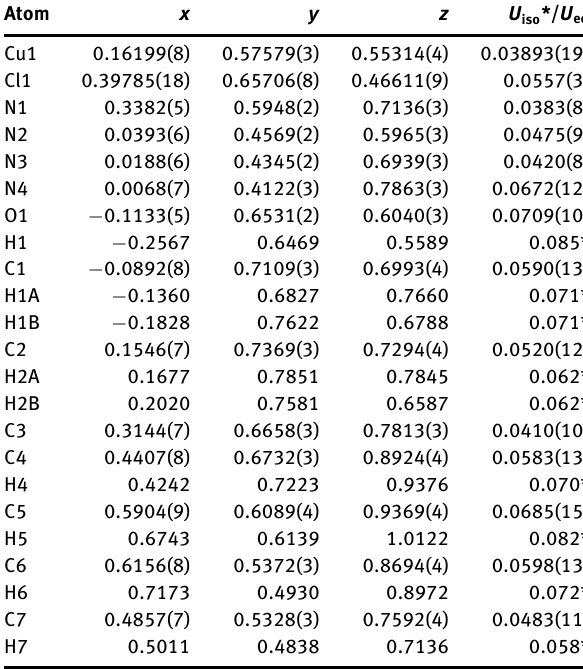
Table 2: Fractional atomic coordinates and isotropic or equivalent isotropic displacement parameters (Å 2